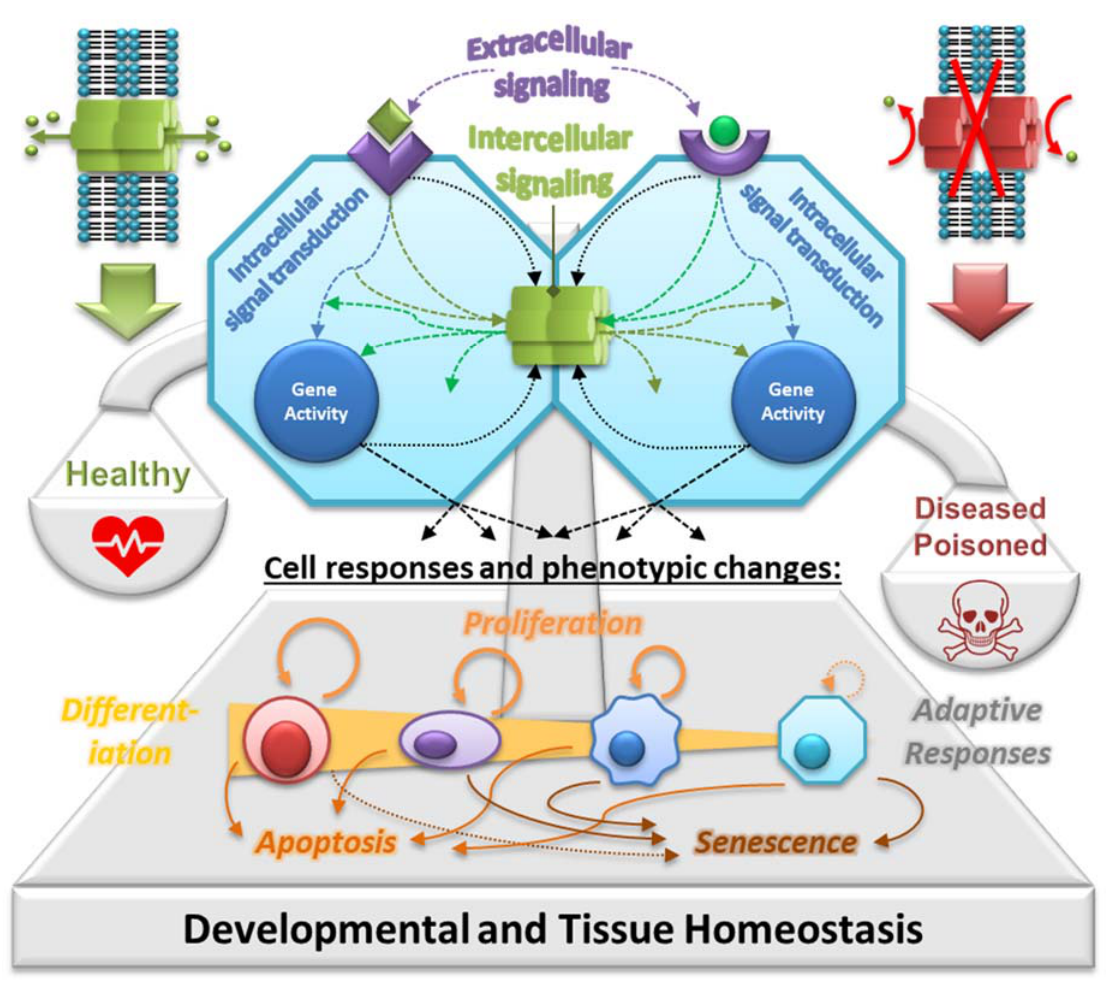
Figure 2. Gap junctions in homeostasis. Extracellular signals, such as growth factors, cytokines, hormones, toxicants, extracellular matrices and cell adhesion molecules, interact with receptor-dependent or receptor-independent targets, activating intracellular signal transduction pathways that induce gene transcription through activated transcription factors. These signals vary for each cell type: embryonic, adult stem, progenitor and terminally differentiated cells. Furthermore, these specific intracellular pathways operate under cascading systems that cross-communicate with each other in controlling the expression of genes that direct the proliferation, differentiation and apoptosis of cells within a tissue. These multiple intracellular signaling checkpoints are further modulated by intercellular signals traversing gap junctions—so-called gap junctional intercellular communication (GJIC). GJIC is crucial for integrating different signals and signaling mechanisms across the tissue, thus maintaining its homeostatic state under physiological conditions in a healthy organism. Abnormal interruption of the integrating signaling mechanism of GJIC by food-related and environmental toxins/toxicants will disrupt the normal homeostatic control of cell behavior. It can lead to an adverse outcome or a disease due to imbalanced proliferation, differentiation and/or apoptosis, which is typically observed, for example, in cancers and their tumor promotion and progression stage. Prepared according to information from [27,30,31].